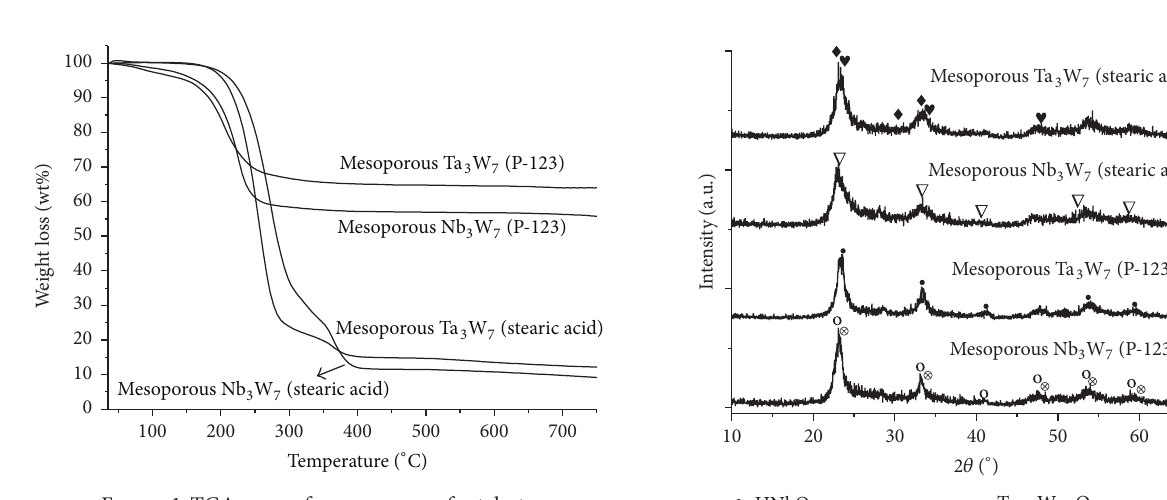
Figure 1: TGA curves for precursors of catalysts.